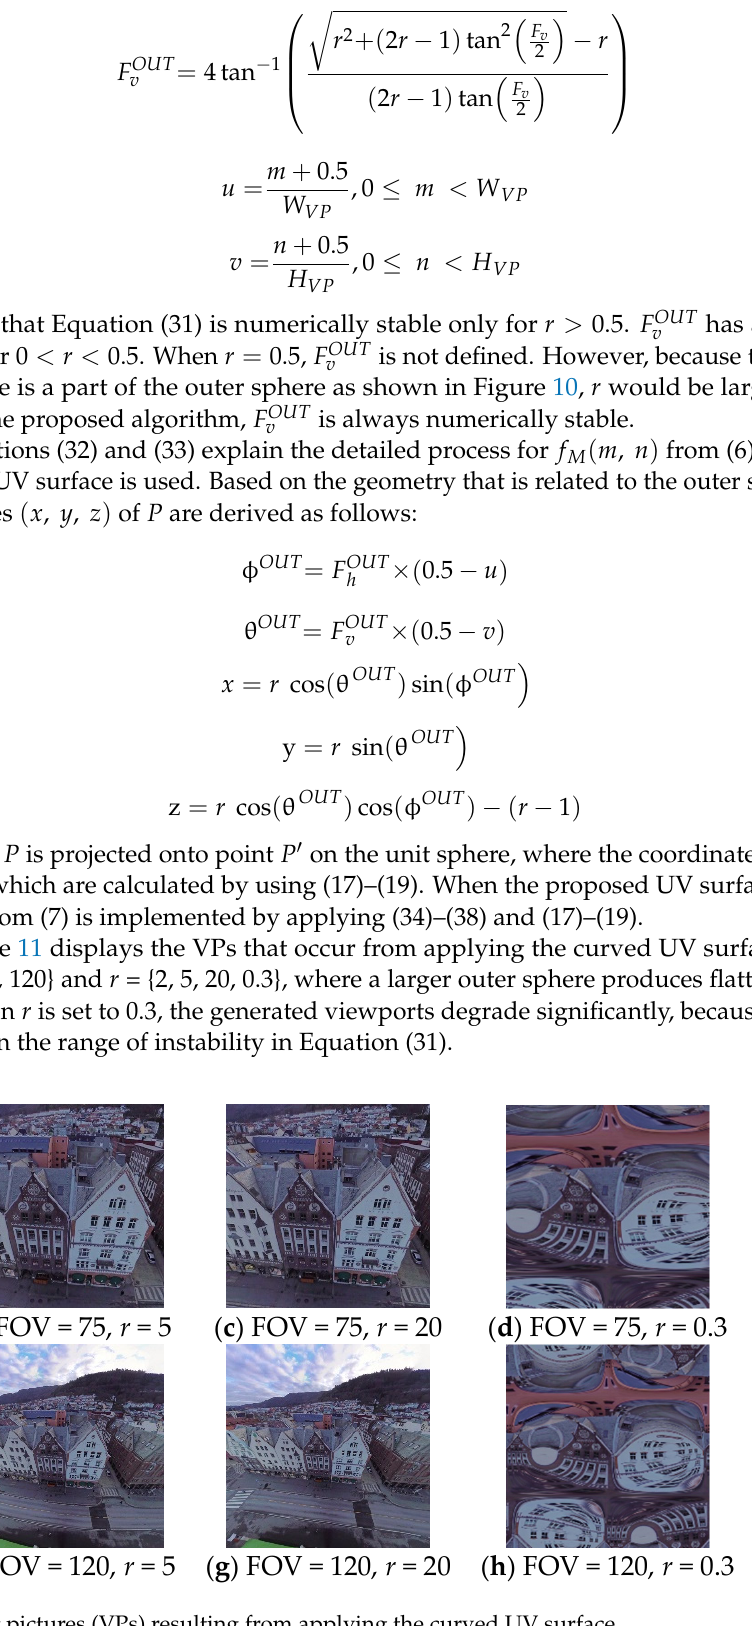
Figure 11. Viewport pictures (VPs) resulting from applying the curved UV surface.